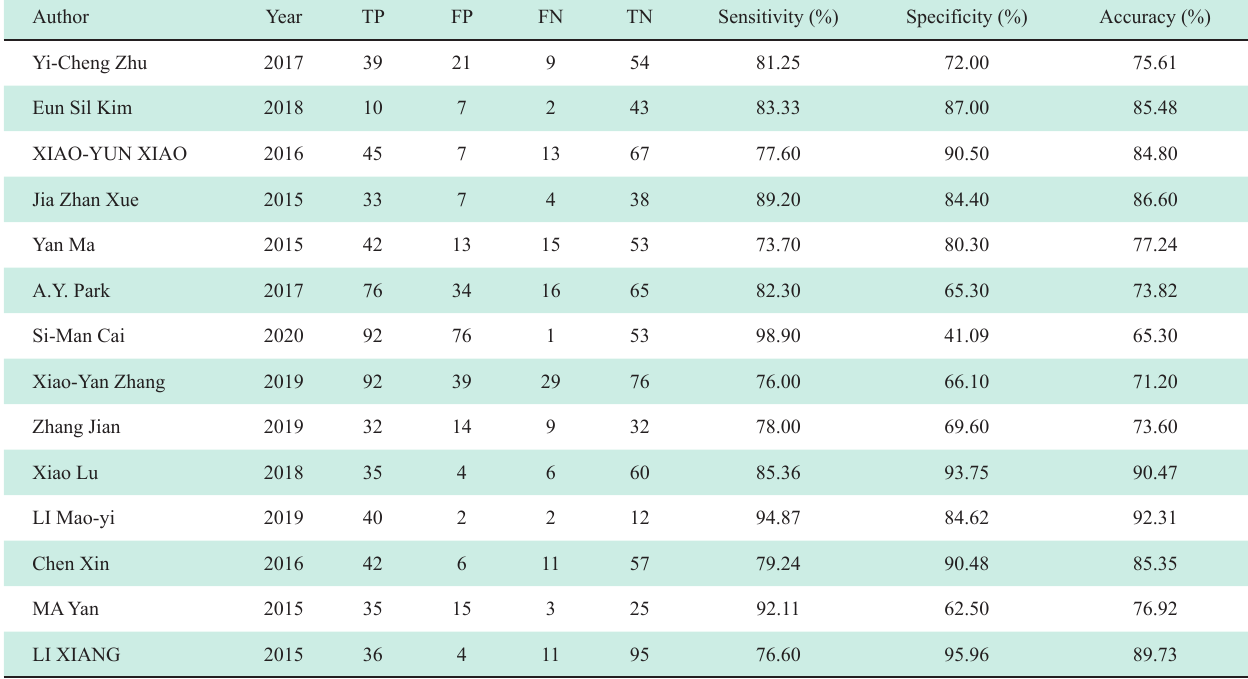
Figure 2 QUADAS-2 risk of bias assessment. Table 2 Baseline data of included